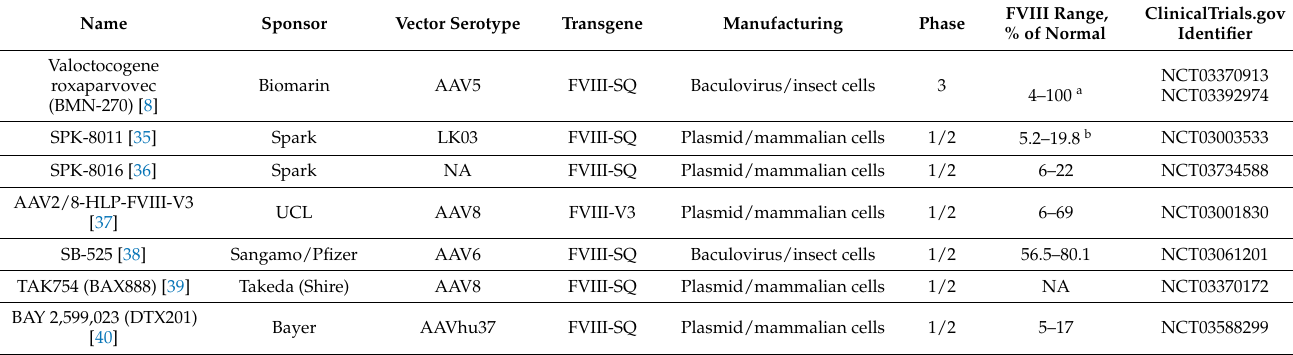
Table 1. Current FVIII AAV liver-directed gene transfer products for hemophilia A in clinical